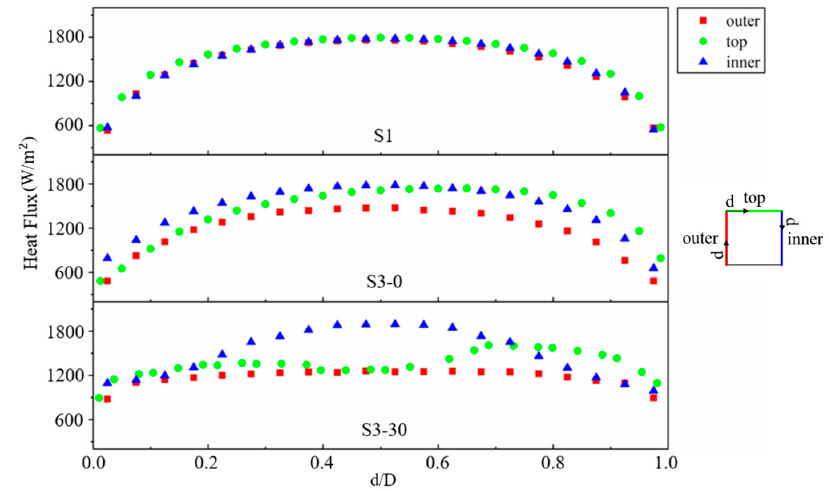
Figure 16. Local wall heat flux distributions of S1, S3-0, and S3-30.